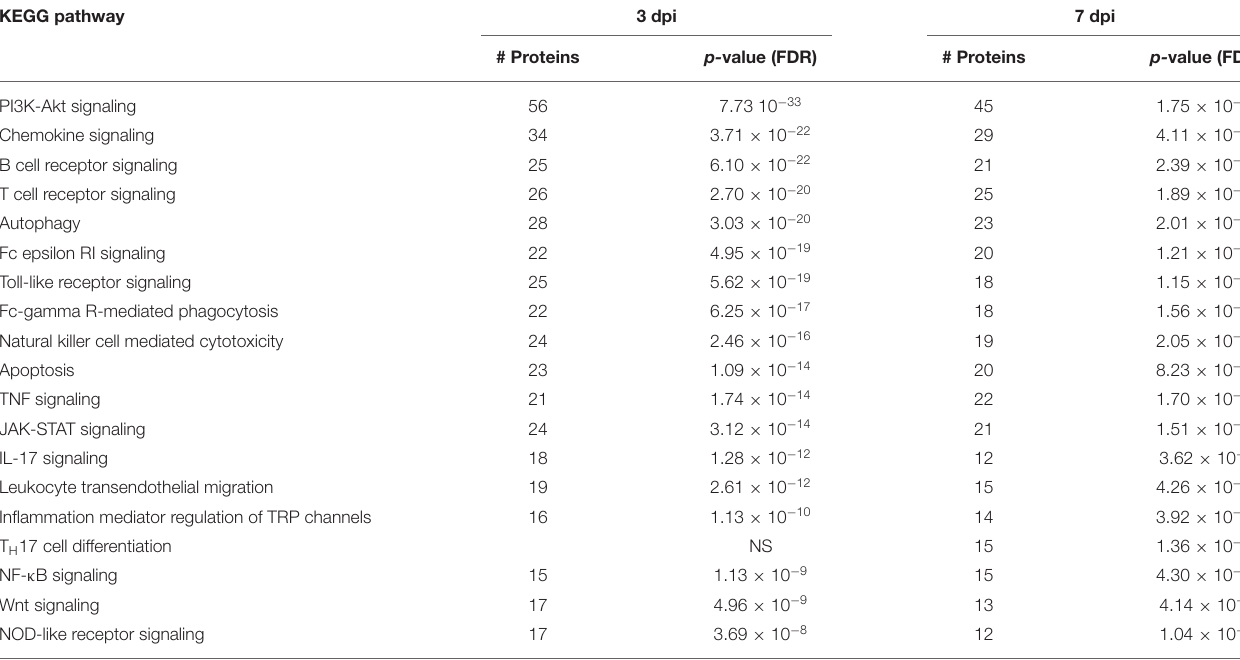
TABLE 2 | KEGG immune pathways enriched from unique peptides in SPORE (compared to CON) birds 3 and 7 days post-inoculation. KEGG